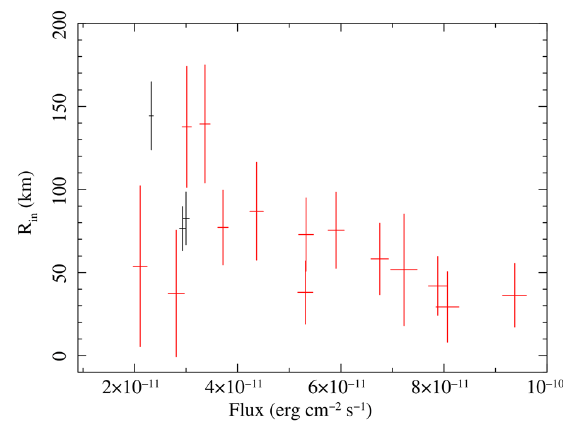
Figure 5. Flux-innermost radius plot, black for 2014 data and red for 2015 data.